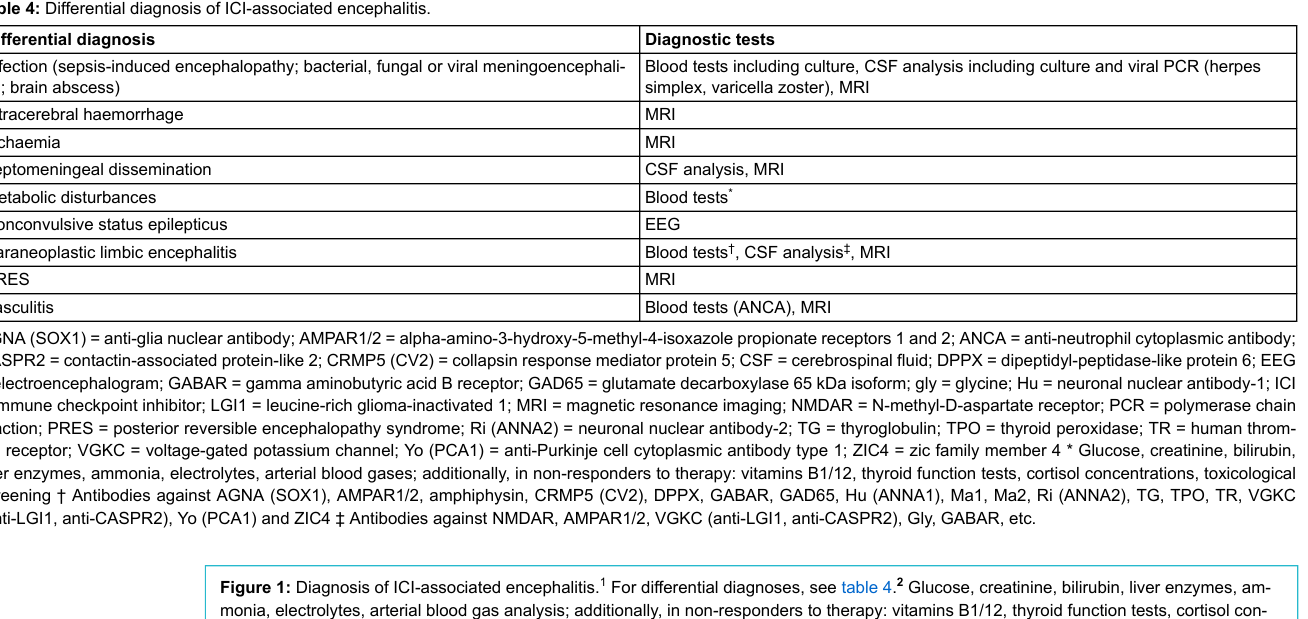
Figure 1: Diagnosis of ICI-associated encephalitis. 1 For differential diagnoses, see table 4. 2 Glucose, creatinine, bilirubin, liver enzymes, am- monia, electrolytes, arterial blood gas analysis; additionally, in non-responders to therapy: vitamins B1/12, thyroid function tests, cortisol con- centration, toxicological screening, ANCA 3 Antibodies against AGNA (SOX1), AMPAR1/2, amphiphysin, CRMP5 (CV2), DPPX, GABAR, GAD65, Hu (ANNA1), Ma1, Ma2, Ri (ANNA2), TG, TPO, TR, VGKC (anti-LGI1, anti-CASPR2), Yo (PCA1), ZIC4 4 Antibodies against